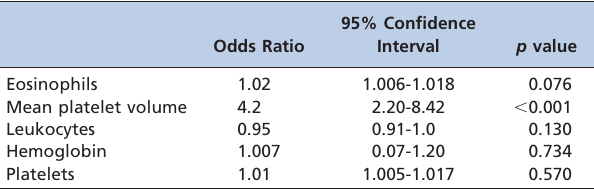
Table 3 - Multiple logistic regression analysis of